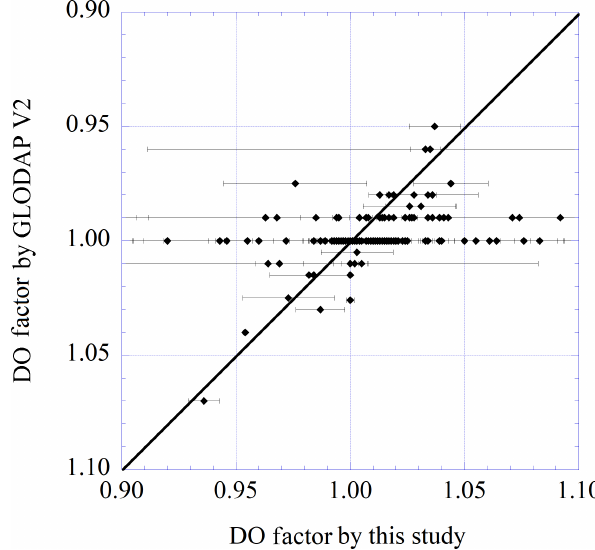
Figure 9. Same as Fig. 7 but for phosphate.